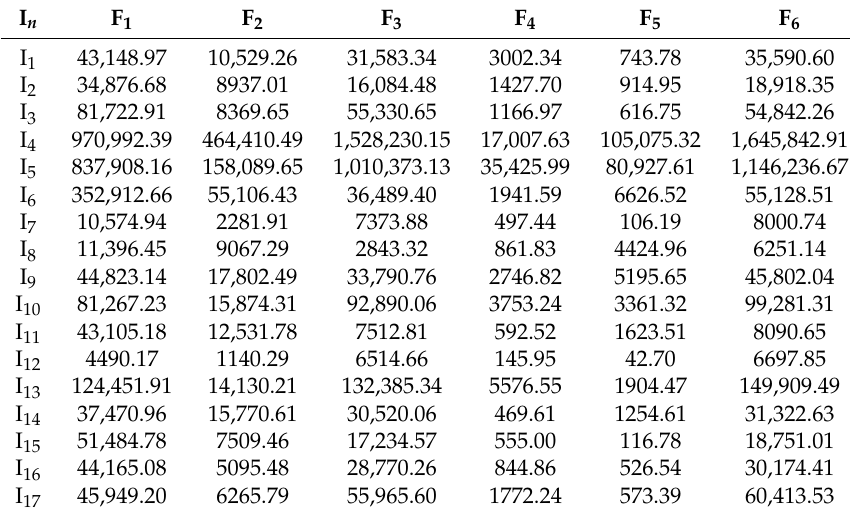
Table 9. Forecast data in